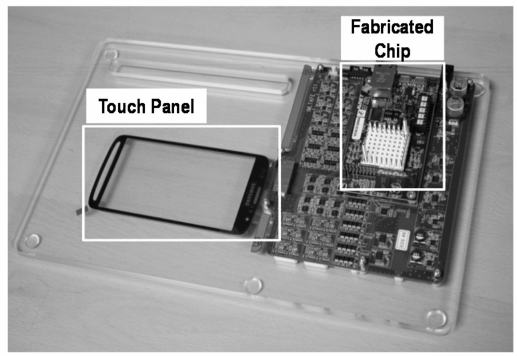
Figure 22. Measurement